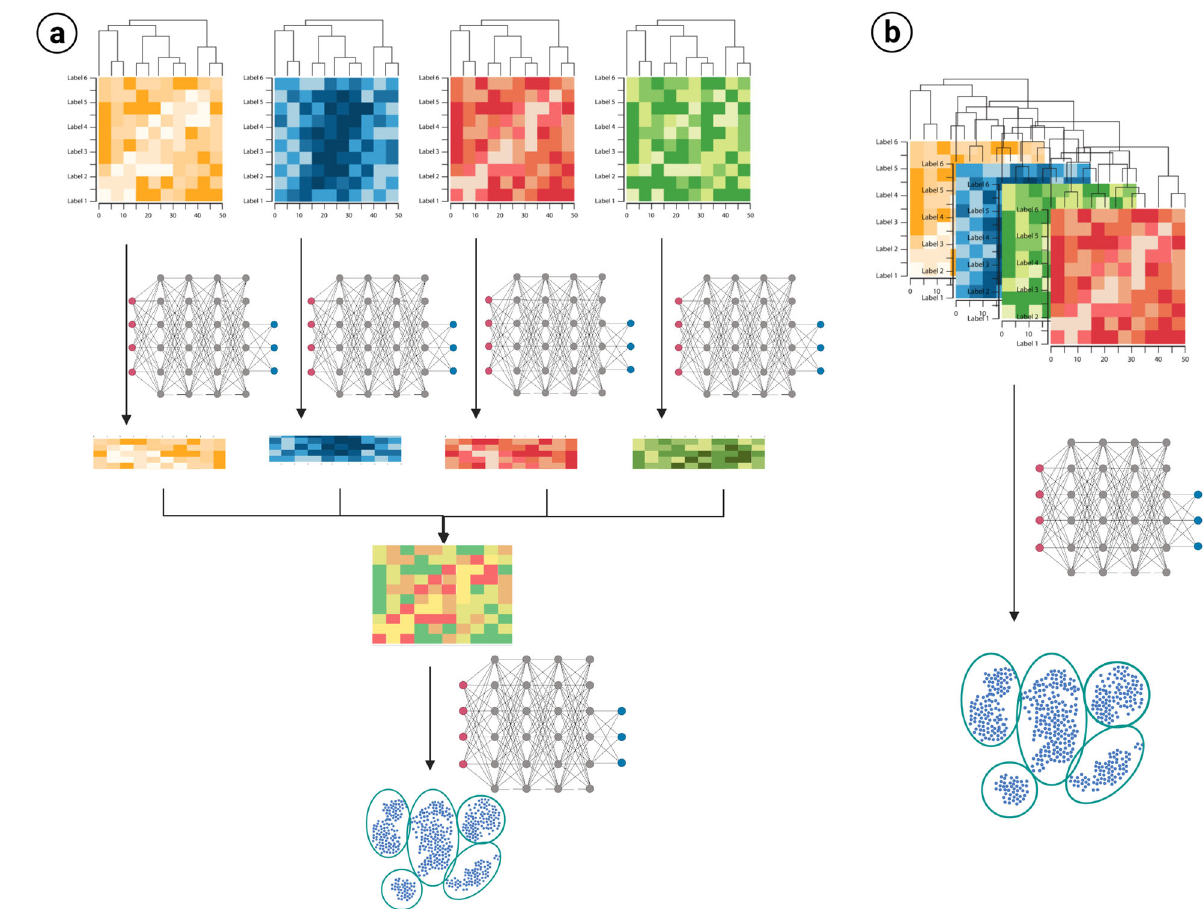
Fig. 3 Algorithmic approaches to multiomic integration. a Late integration applies transformation or modeling for each of the different ‘ omic datasets, and these are later integrated to construct a model. b Early integration concatenates all the different datasets and constructs a single model based on all the data. Clustering models and transformations (presented only as deep networks) can vary according to the approach and algorithm selected. Created in